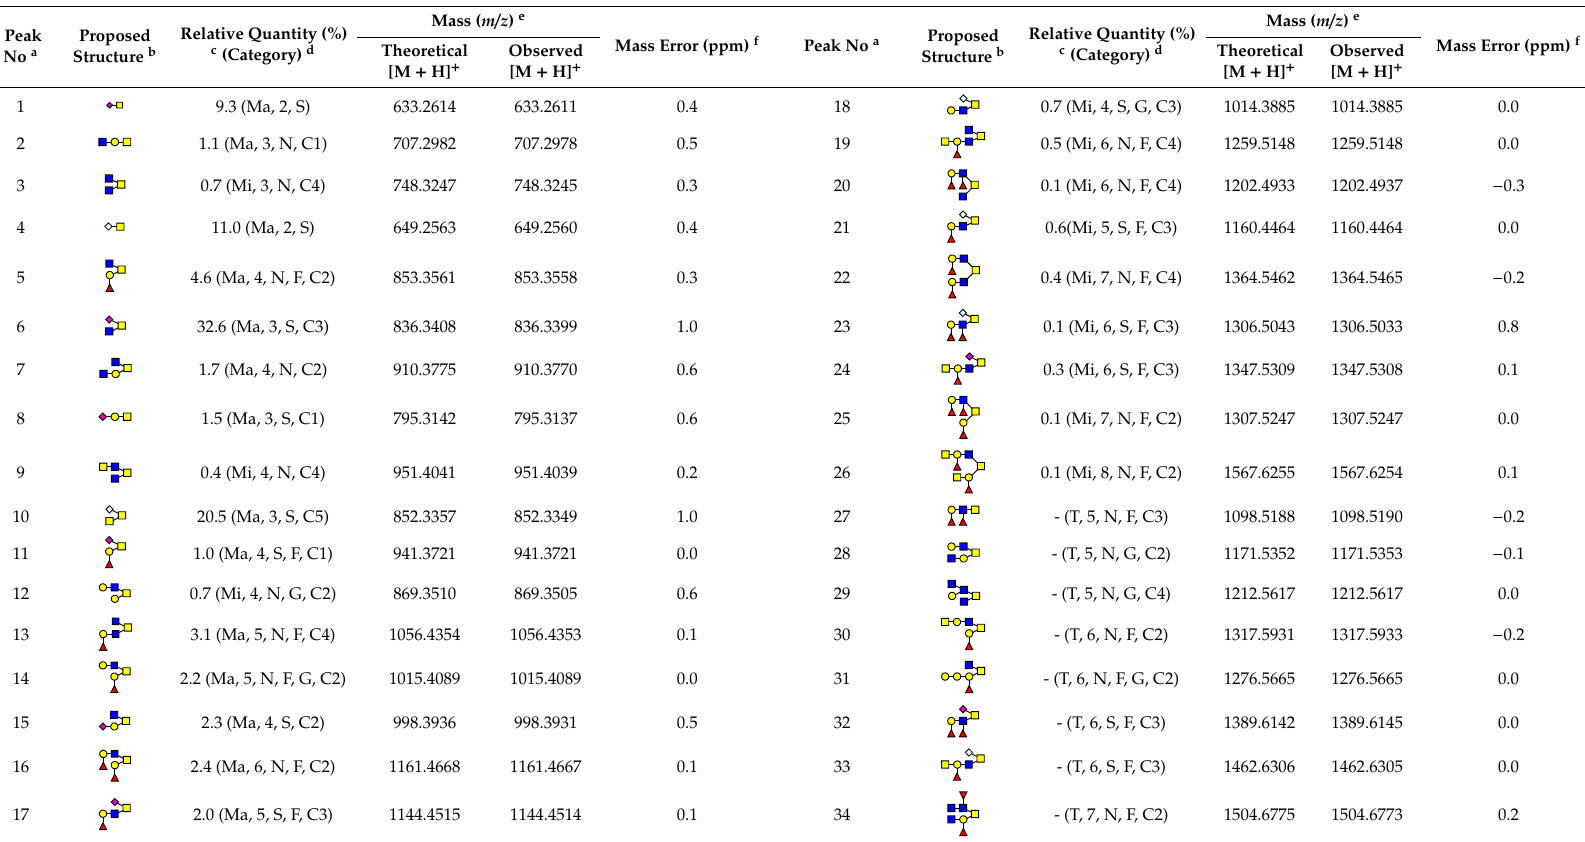
a Peak numbers correspond to peak numbers in Figure 1. b , GlcNAc; , GalNAc; , Gal; , Fuc; , Neu5Ac; , Neu5Gc. c Quantity (%) of each AB-labeled major and minor O -glycan (Peaks 1–26) relative to total O -glycans was determined from the EIC areas for all observed charge states and the total EIC area for all O -glycans (as 100%) using LC–ESI–HCD–MS/MS. Trace O -glycans (Peaks 27–34) were obtained from ProA-labeled O -glycans. d Major (Ma, >1.0%; relative quantities of each glycan among total O -glycans as 100%), minor (Mi, 0.1%–1.0%), and trace (T, <0.1%) O -glycans; di- (2), tri-